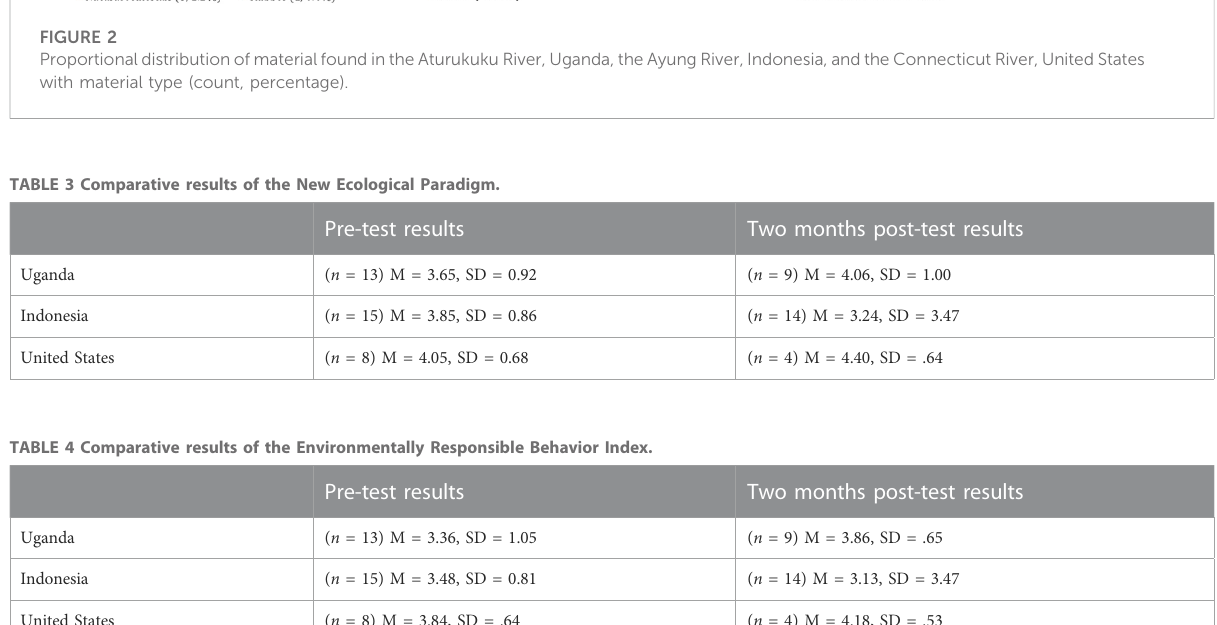
Table 2 and proportional distribution of each sample by site is shown in Figure 2.